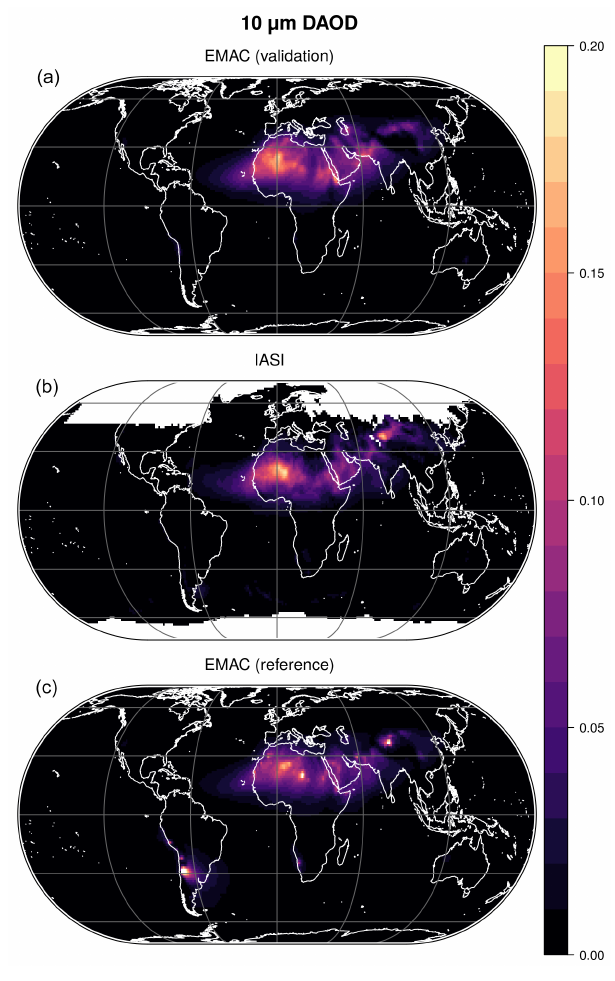
Figure 13. Annual mean for 2011 of the DAOD at 10µm wave- length observed by IASI (b) and simulated by EMAC with (“valida- tion”, a ) and without (“reference”, c ) revision of the dust emission scheme. The revised dust emissions enhance the correlation of the AOD pattern from 0.79 to 0.89 and the skill score from 0.64 to